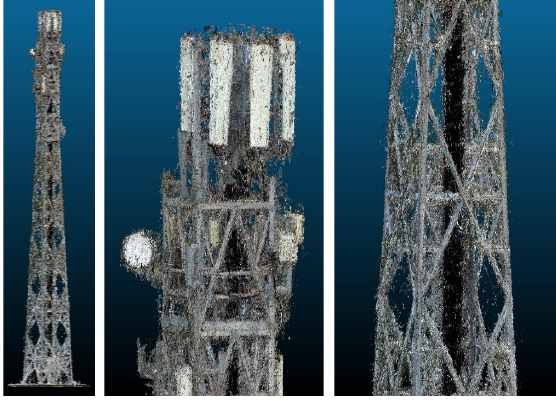
Figure 6. Dense cloud of the CASIC